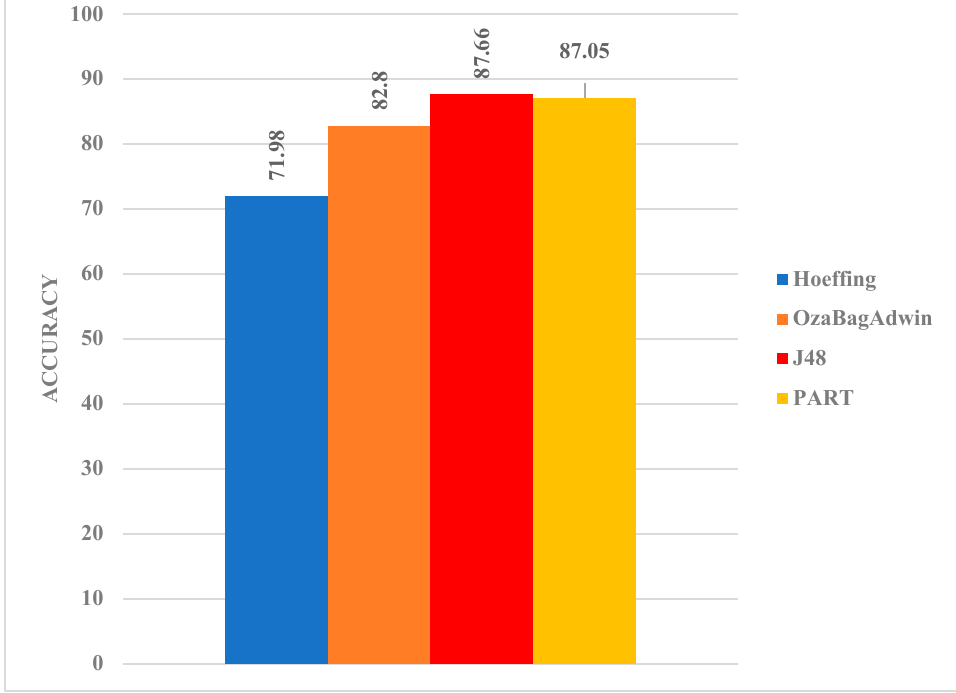
Figure 4. Model comparison based on the multiclass classification task.